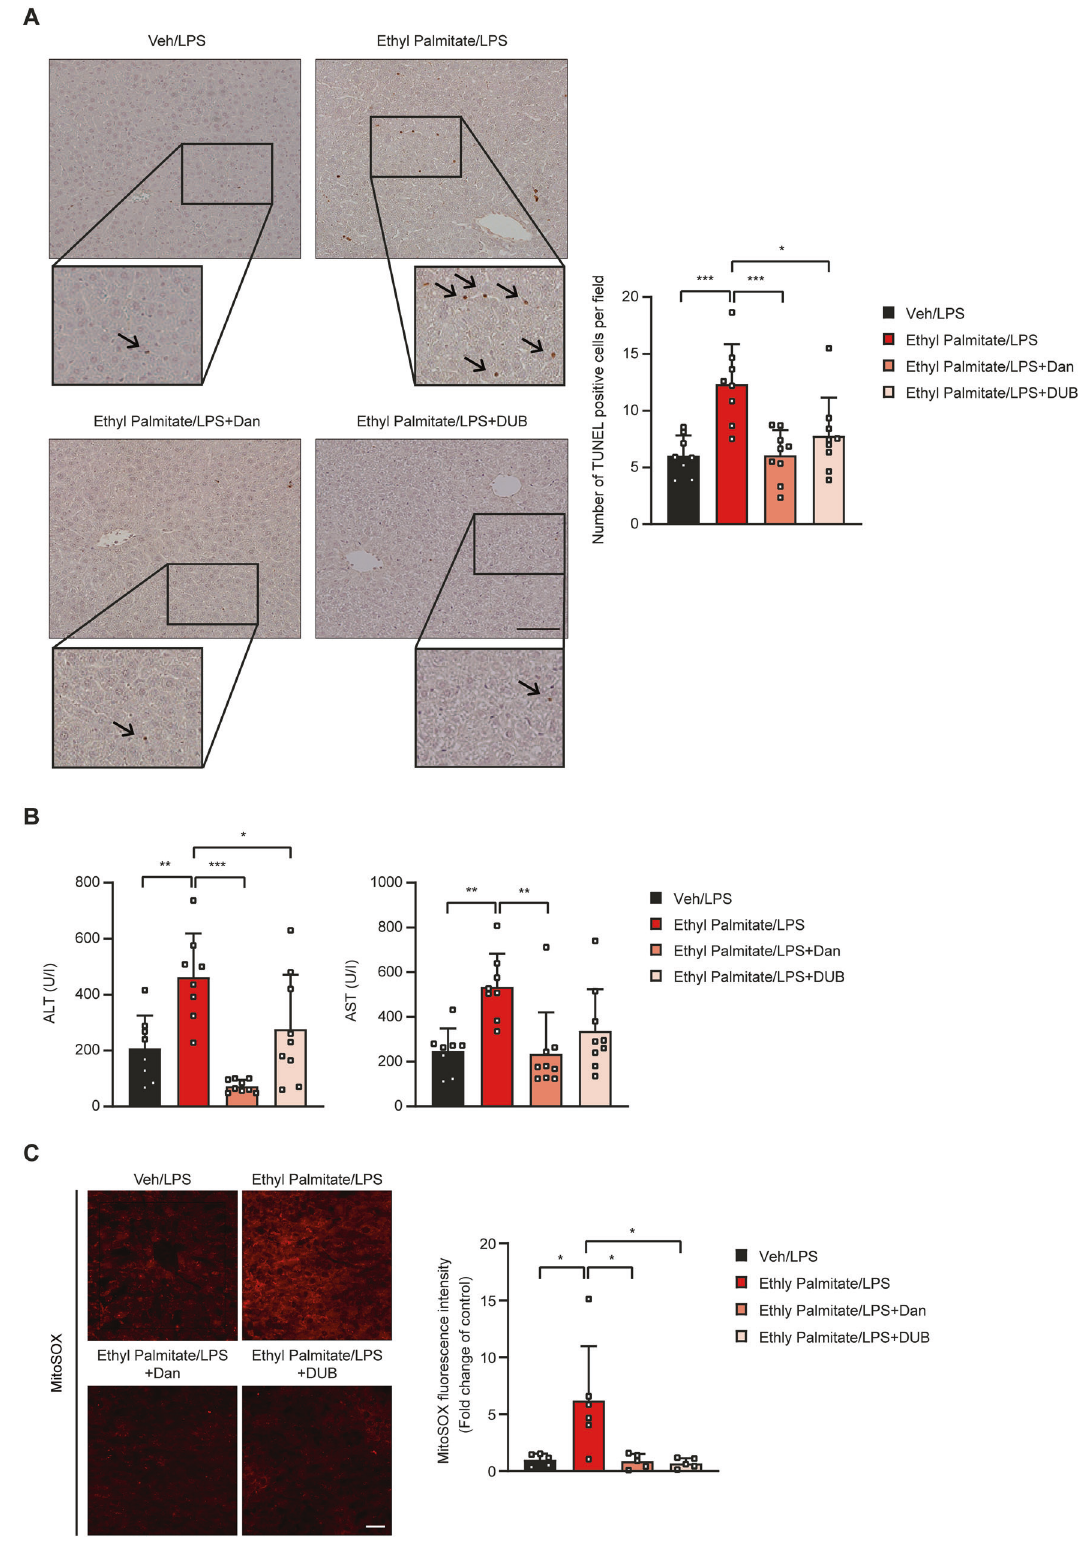
Fig. 5 In vivo lipotoxicity. A After injection of ethyl palmitate and LPS to C57BL/6 mice with or without pretreatment with dantrolene or DUB, cell death was evaluated by TUNEL staining of hepatic sections (right). Representative TUNEL staining is presented (left) ( n = 8 – 9/group). Insets were magni fi ed. Scale bar, 200 μ m. B In serum from mice of ( A ), ALT and AST levels were determined using a blood chemistry analyzer ( n = 8 – 9/group). C In frozen hepatic sections from the mice of ( A ), mitochondrial ROS accumulation was determined by MitoSOX staining ( n = 5 – 6/group) (right). Representative fl uorescence images are shown (left). Scale bar, 20 μ m. Data are presented as the means±SD. All statistical comparisons were performed using one-way ANOVA with Tukey ’ s multiple comparison test. (* P <0.05; ** P < 0.01; *** P < 0.001; ns not signi fi cant).